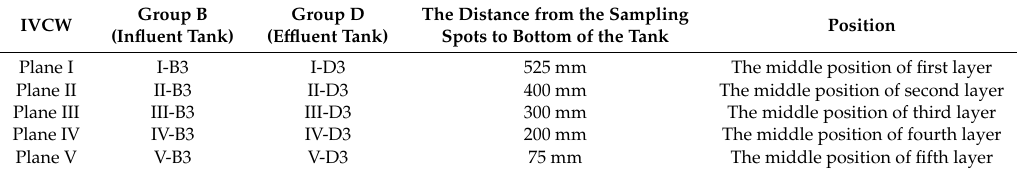
Figure 1. Distribution of substrate layers, sampling pipes and greenhouse gas collecting device of integrated vertical-flow constructed wetlands (IVCW). (ø is the diameters of pipe). Table 1. Distribution of internal sampling points in the influent and effluent tank.